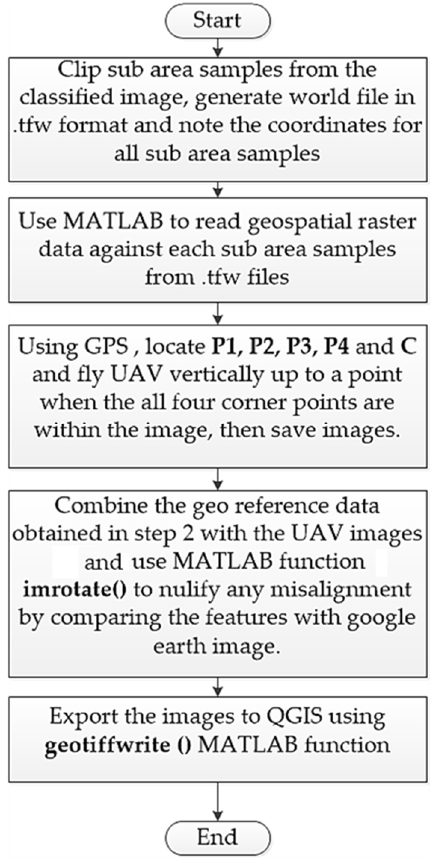
Figure 6. Flowchart explaining how to collect and process ground data using an UAV.